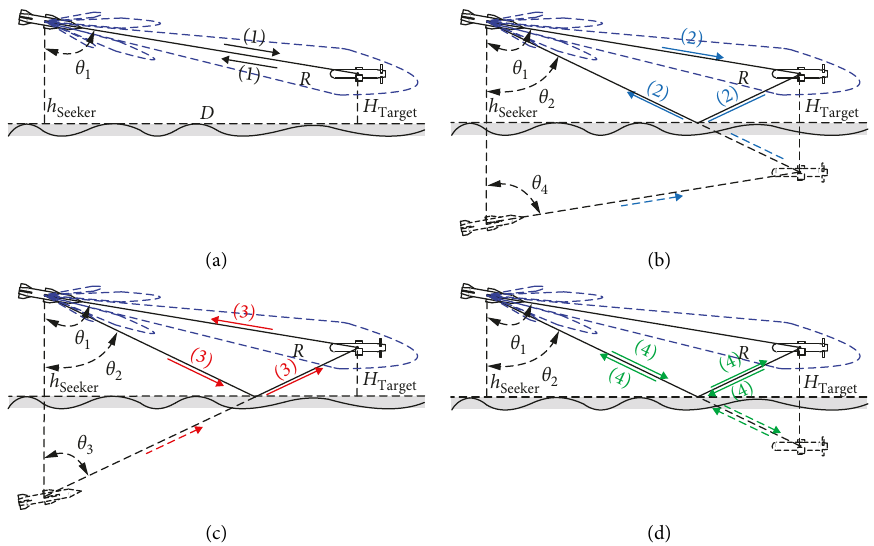
Figure 2: The schematic diagram of the modified four-path model. (a) Path1. (b) Path 2. (c) Path3. (d) Path4.